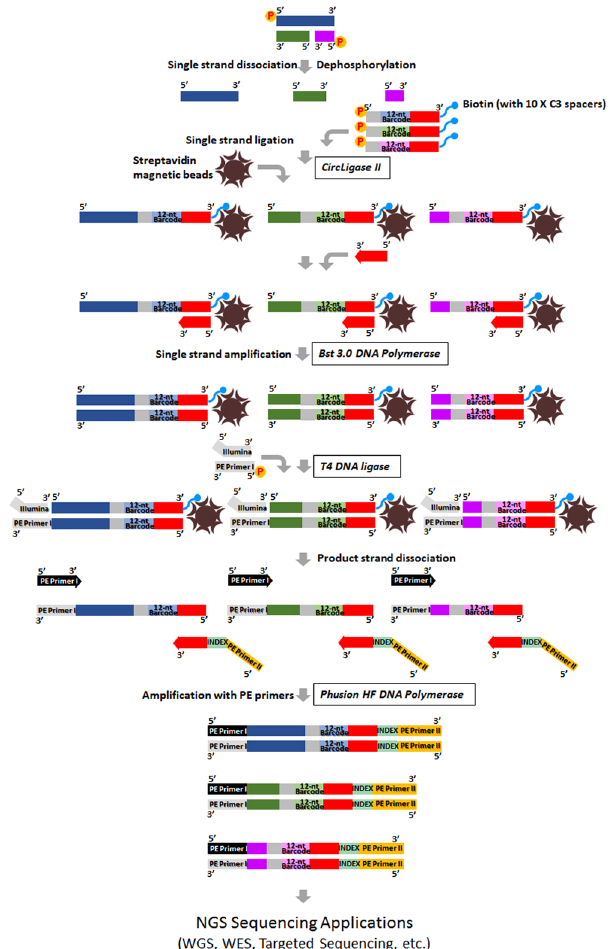
Figure 1. Overview of DEEPER-Library construction. A double-stranded DNA molecule (bearing a damaged strand or not) is heated to dissociate complementary DNA single strands. A barcoded (12nt) single-stranded adapter is appended to the 3 ′ end of a single-stranded DNA molecule and the entire molecule is immobilized on a streptavidin-bead. A PCR primer complementary to the 3 ′ sequence on every adapter is added as a primer to synthesize the complementary sequences of the initial single-stranded DNA molecule and the barcode. Illumina PE sequencing adapter is appended to the 3 ′ end of the newly synthesized complementary single- stranded DNA. PE primer I and a joined primer of single - stranded adapter – index - PE primer II are used to amplify the DNA fragments in the library. After amplification, the library is ready for direct NGS sequencing or subgenomic capture for targeted